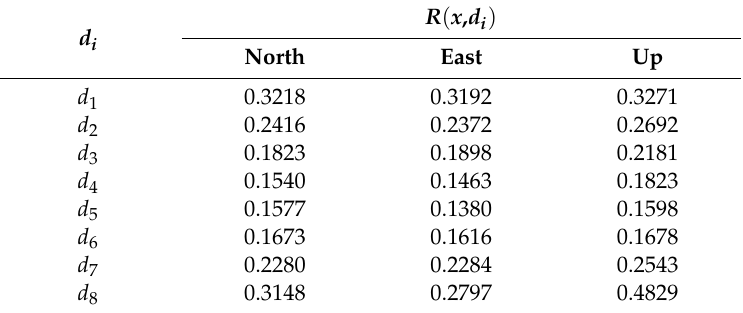
Figure 7. Periodic power spectrum of reconstructed component of each layer. Table 1. Correlation coe ffi cients between original time series and reconstructed component of each wavelet